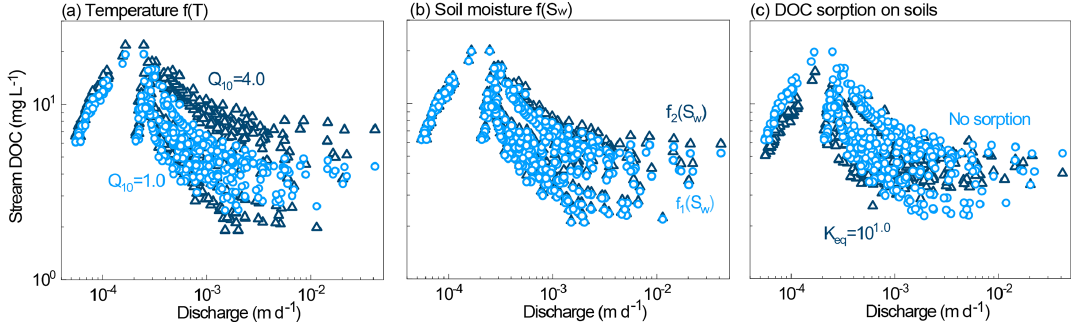
Figure 11. C–Q relationships under different (a) T , (b) f (S w ) , and (c) sorption equilibrium constants K eq for the two extreme cases. The C–Q patterns were similar in all cases, although the extent of dilution slightly changed. This indicates potential factors other than reaction kinetics and thermodynamics that regulate C–Q patterns.